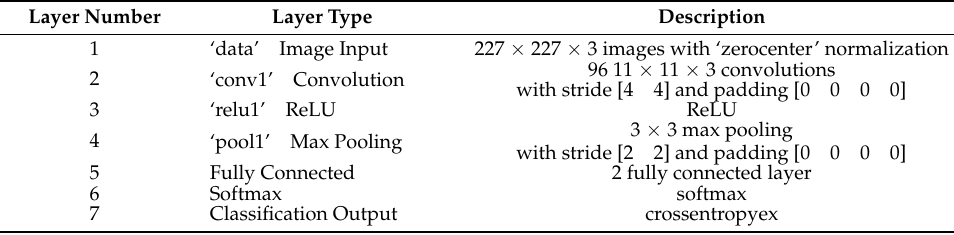
Table 4. Final structure of the CNN network used.